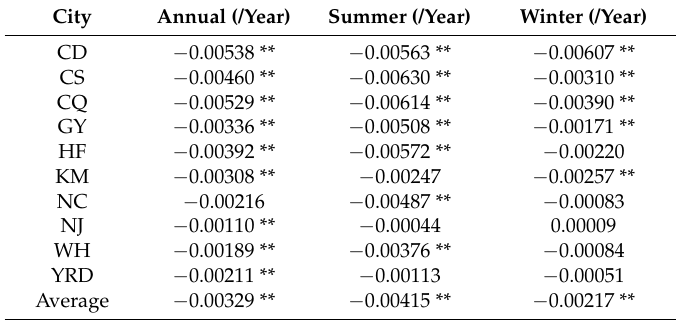
Table 5. Temporal trends of ∆ EVI at 10 cities in YRB, China.